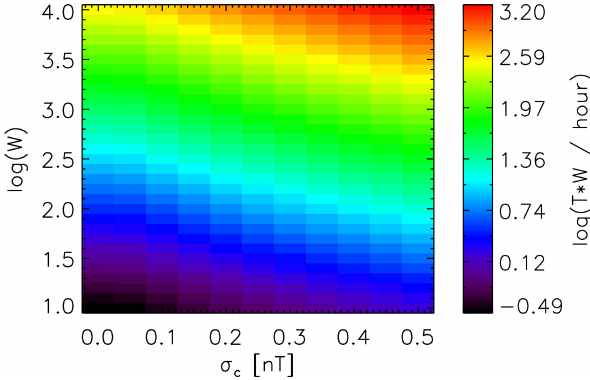
Figure 4. Required solar wind measurement time T (σ c )W to obtain W offset estimates from intervals with σ > σ c , from which final offsets may be computed in all